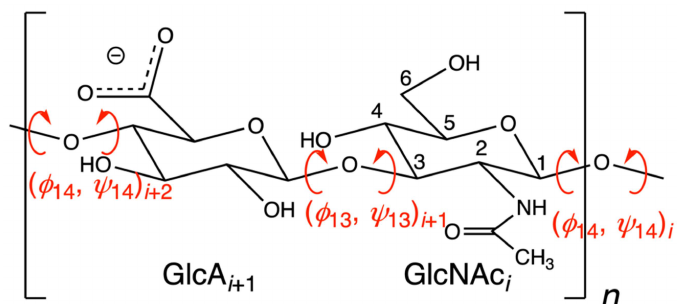
Figure 1. Chemical structure of the glycosaminoglycan biopolymer hyaluronan. GlcA = β -D- glucuronate; GlcNAc = N -acetyl- β -D-glucosamine. The GlcA carboxylic acid moiety is expected to be deprotonated at physiological pH and is represented as such. Rotatable dihedrals in β 1-4 and β 1-3 glycosidic linkages are in red. The index n indicates the overall length of the polymer. The index i uniquely identifies each monosaccharide in the polymer. IUPAC conventions are used to define ( φ 14 , ψ 14 ) and ( φ 13 , ψ 13 ) and assign to each an index i [41]. For example, ( φ 14 , ψ 14 ) i is defined by (O5 i -C1 i - Numbering of carbon atoms follows the convention for GlcNAc in the figure, with oxygen atoms assuming the number of the carbon to which they are attached. The ring oxygen is considered O5, as it is attached solely to C5 in the linear aldose form of the monosaccharide. Glycosidic linkage oxygen atoms assume the number of the attached carbon atom of the monosaccharide having the lower index i in the relevant disaccharide